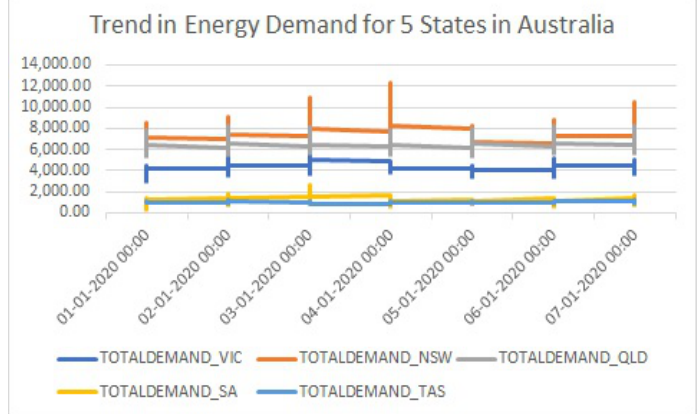
Figure 5. Energy Demand comparison for 7 consecutive